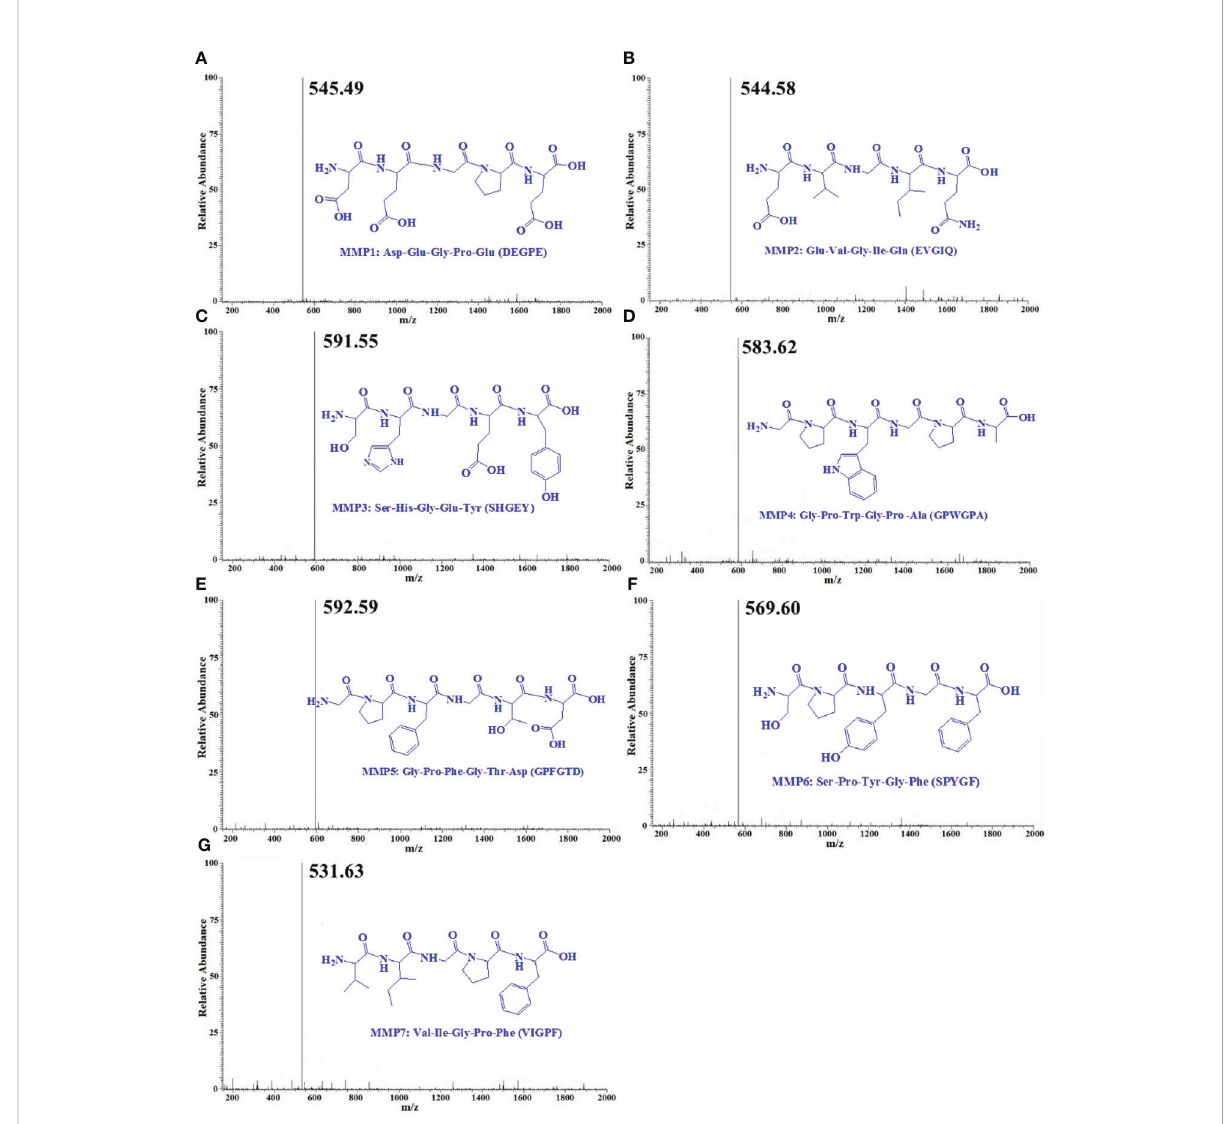
FIGURE 4 Mass spectrogram of seven ACEi peptides (MMP1- MMP7) from protein hydrolysate of miiuy croaker swim bladders (MSCH). (A) MMP1; (B) MMP2; (C) MMP3; (D) MMP4; (E) MMP5; (F) MMP6; (G)